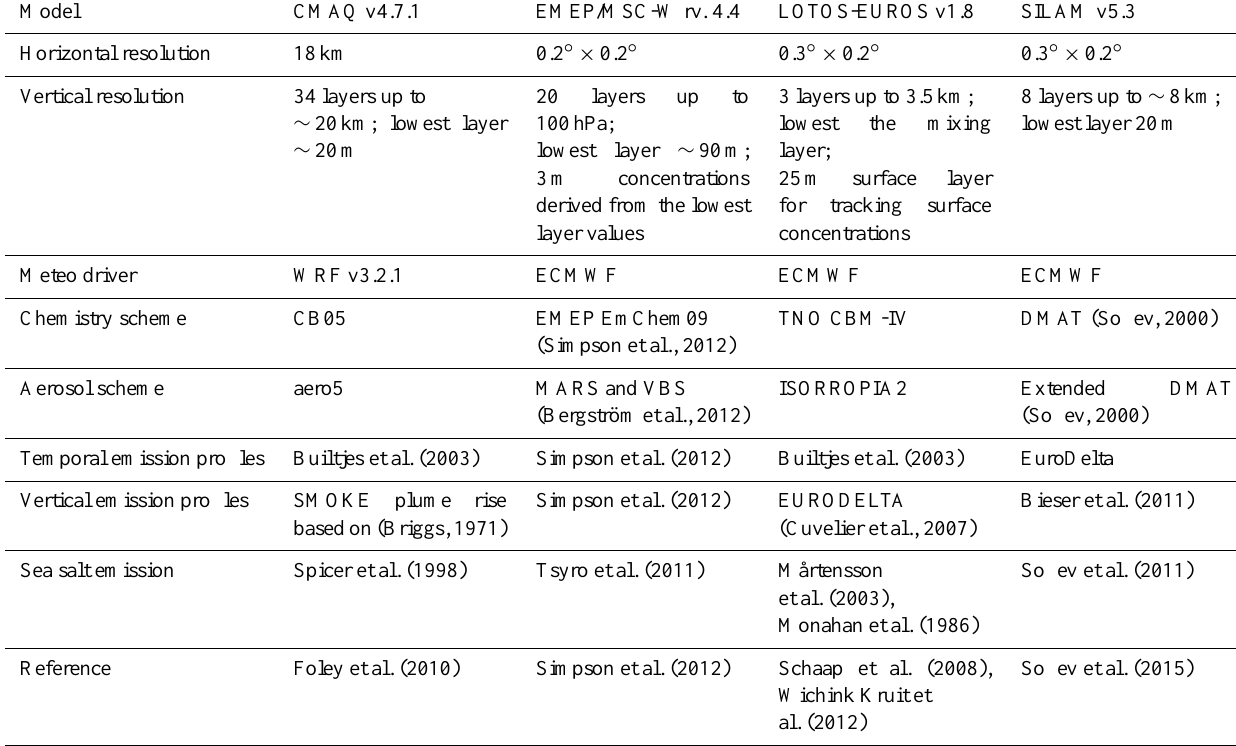
Table 1. Model setup.